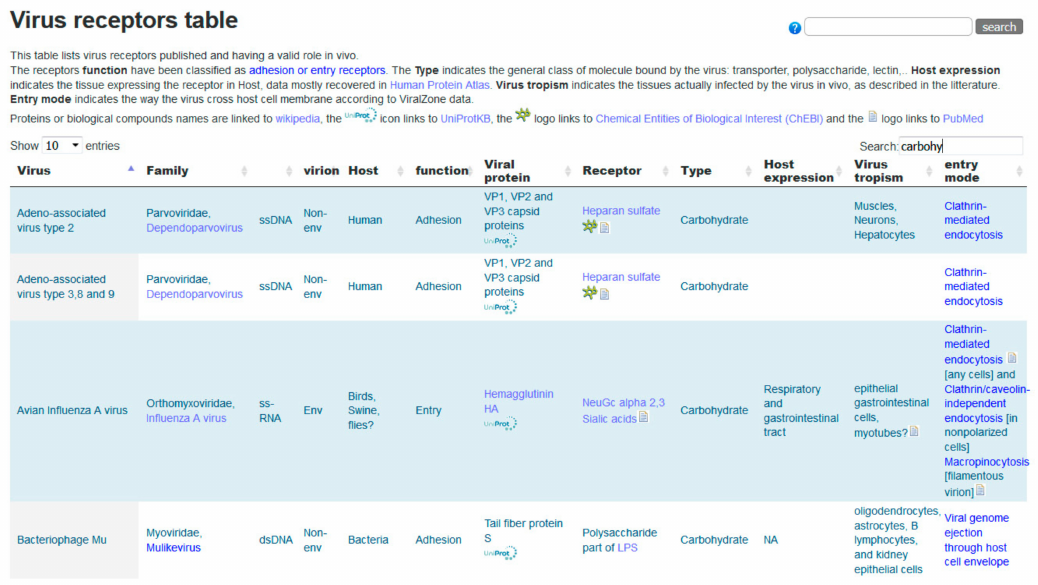
Figure 4. Excerpt of the ViralZone virus receptor table (https: // viralzone.expasy.org / 5356). The screenshot displays the first four carbohydrate receptors of